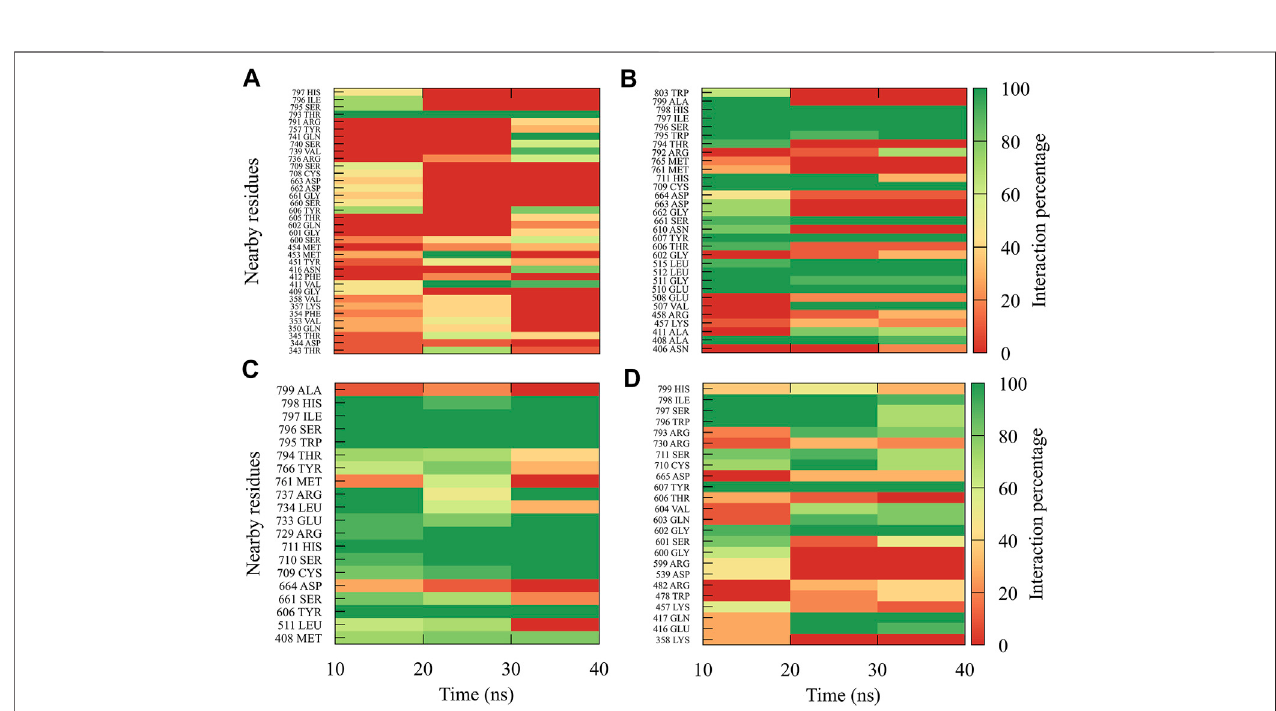
FIGURE 9| Contact frequency maps for the compound 7sd , bound tothe region ofthe GDD motif in the RdRp domain of the (A) DENV1, (B) DENV2, (C) DENV3, and (D) DENV4. Red represents that the contact frequency was 0%, while green represents that the contact frequency was 100%.